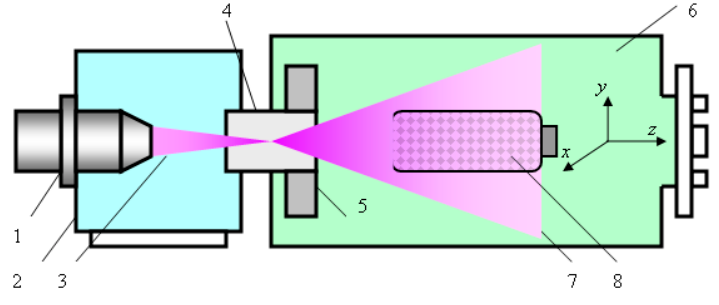
Figure 1. Electron-beam plasma-chemical reactor and scheme of the treatment procedure: 1—electron-beam gun; 2—high vacuum chamber; 3—electron beam; 4—injection window; 5—electromagnetic scanning system; 6—working chamber; 7—EBP cloud; 8—mixing device with polysaccharide powder to be treated.